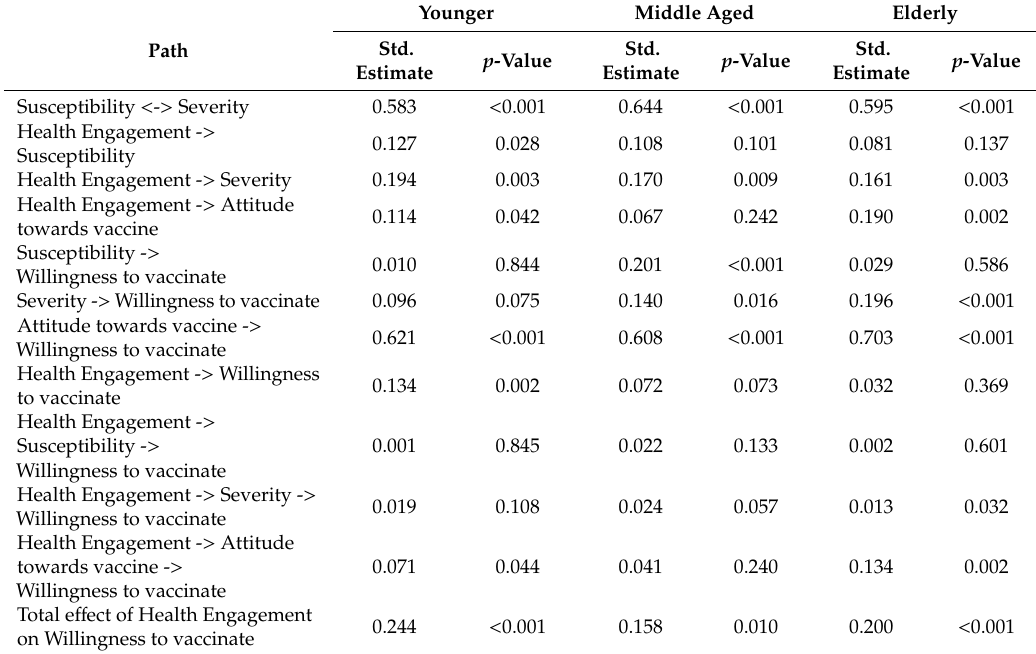
Table 5. Regression weights and e ff ects of engagement on willingness to vaccinate by age group.